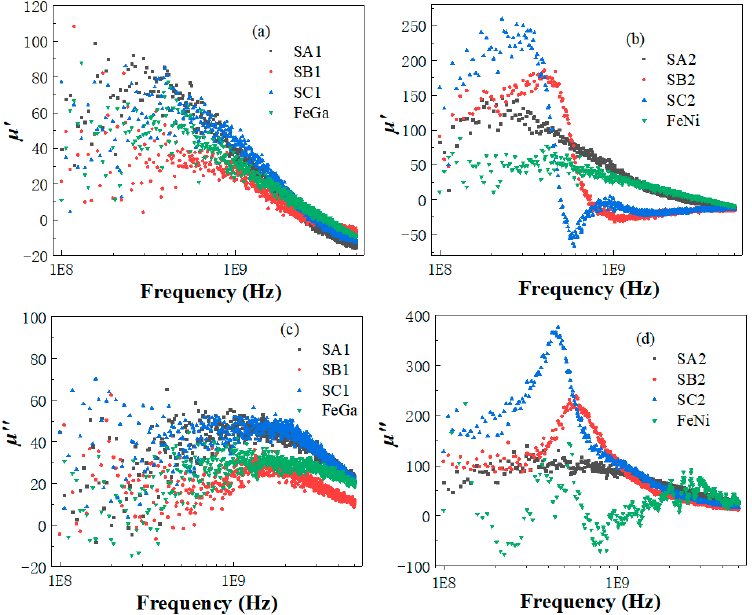
Figure 5. The real part and imaginary part of complex permeability of FeNi / FeGa (FeGa / FeNi) films, FeGa and FeNi. ( a , c ) show the real and imaginary part of SA1, SB1, SC1 and FeGa. ( b , d ) show the real and imaginary part of SA2, SB2, SC2 and